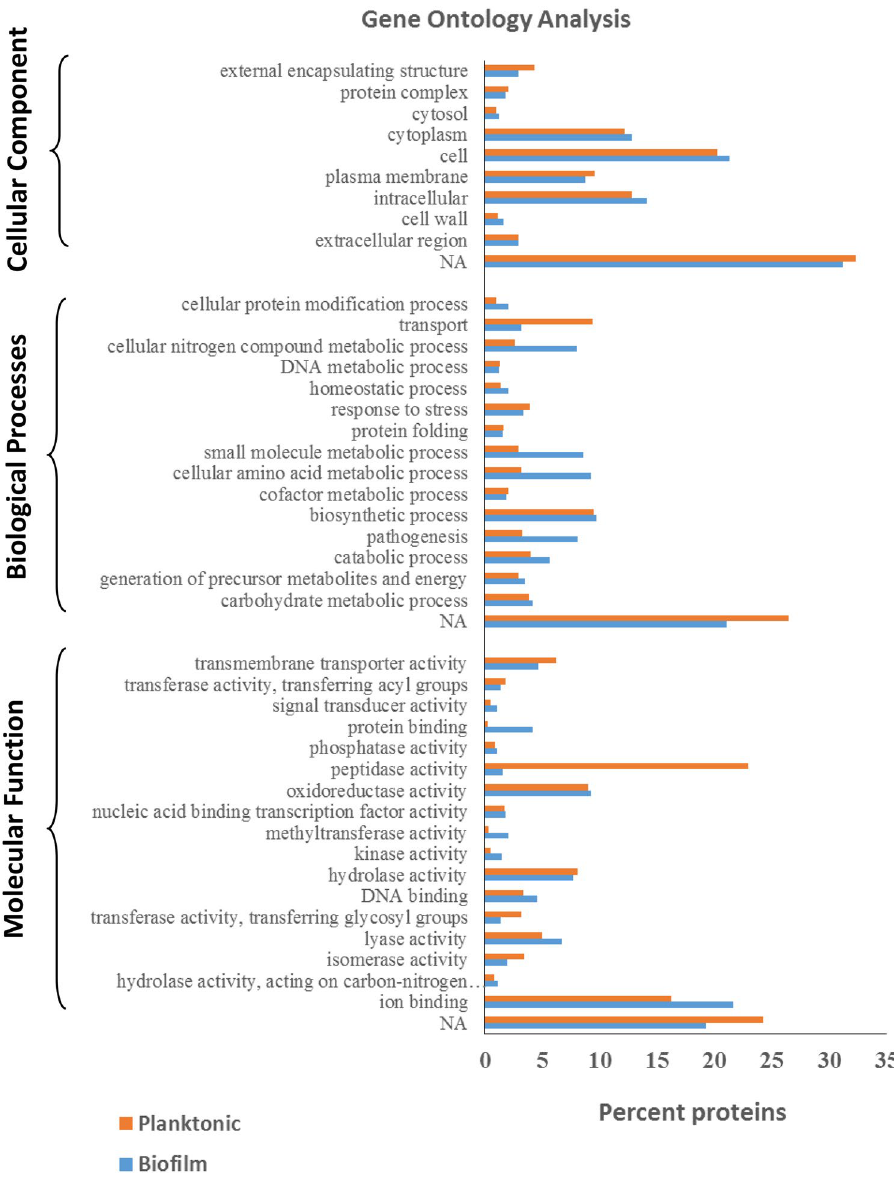
Figure 3. Gene Ontology analysis of P. intermedia proteomes from biofilm and planktonic cells. Gene Ontology annotation was achieved using Blast2GO and an online software “CELLO2GO”. Protein sequences were grouped into 3 categories based on their properties and